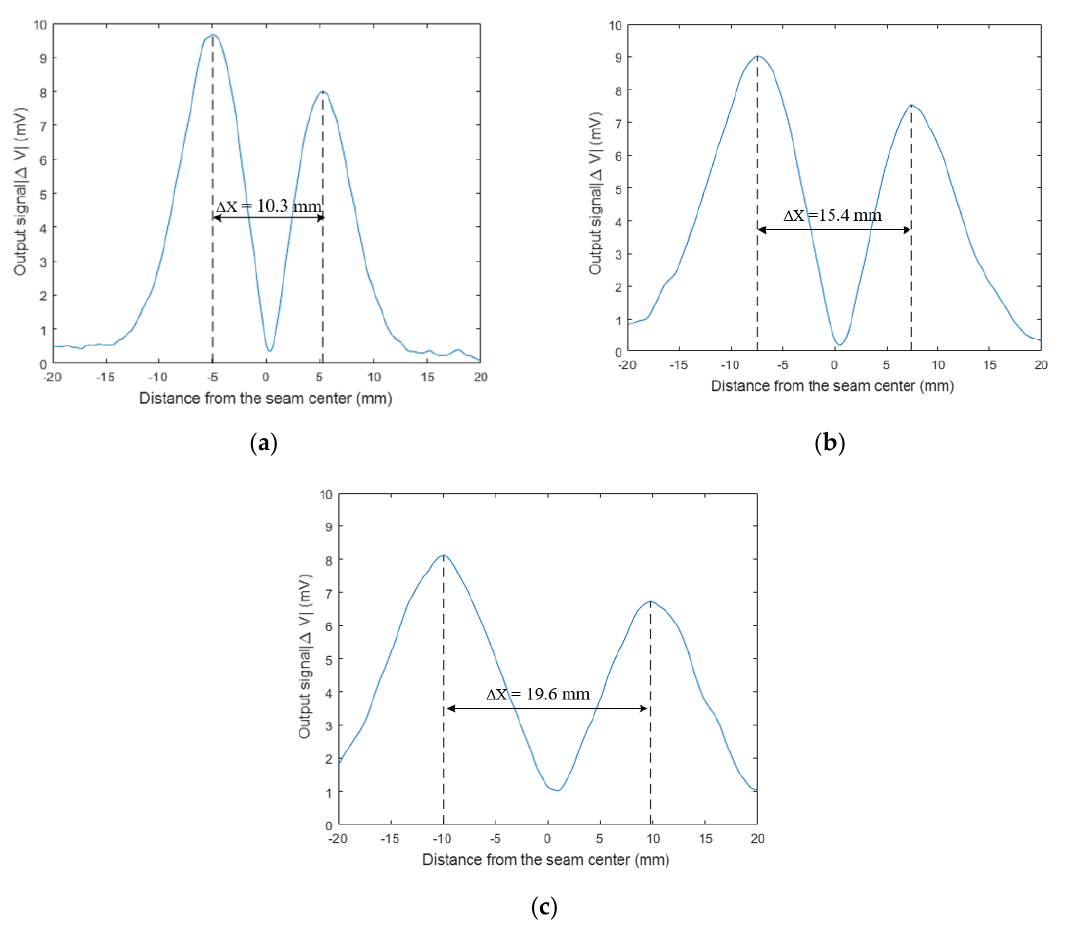
Figure 10. Change of relationship between the sensor-output voltage ∆ V and coil outer diameter ( a ) 10 mm; ( b ) 15 mm; and ( c ) 20 mm.